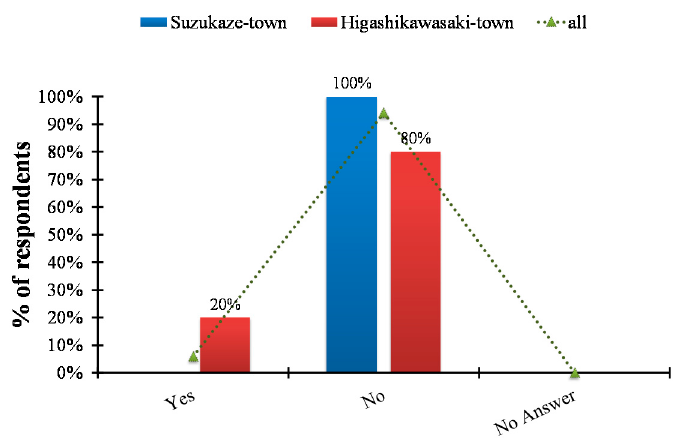
Figure 15. Proportion of respondents who evacuated during the event (n = 5 for Higashi-Kawasaki town, n = 12 for Suzukaze town).